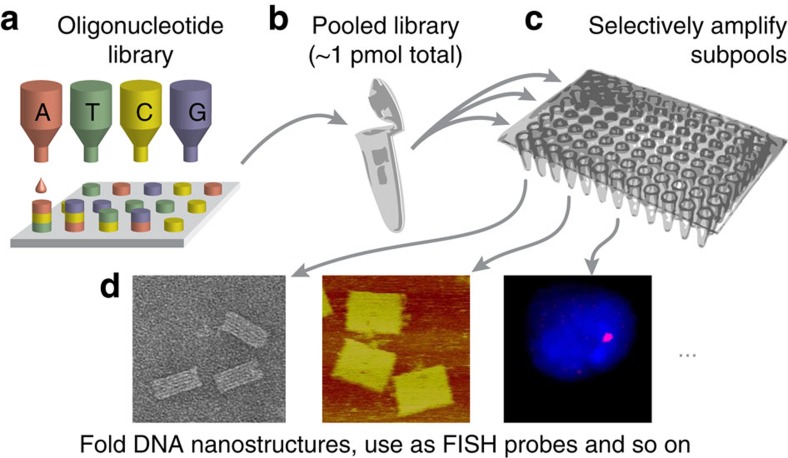
Schematic workflow of oligonucleotide amplification from oligonucleotide libraries.(a) Production of an oligonucleotide library. (b) All strands of the library combined typically add to only few picomoles. (c) Aliquots of the library are selectively amplified by circle-to-circle amplification up to a billionfold. An amplified subpool only contains a subset of oligonucleotides that is required for a certain experiment such as (d) the folding of a specific DNA nanostructure or to hybridize to a chromosomal target region for fluorescence in situ hybridization imaging.